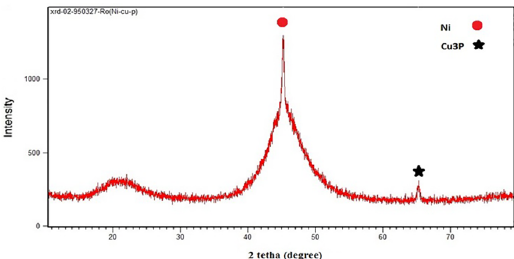
Figure 9. XRD analysis of Ni-P- 3(gr/lit) Cu coating prior to heat treatment.